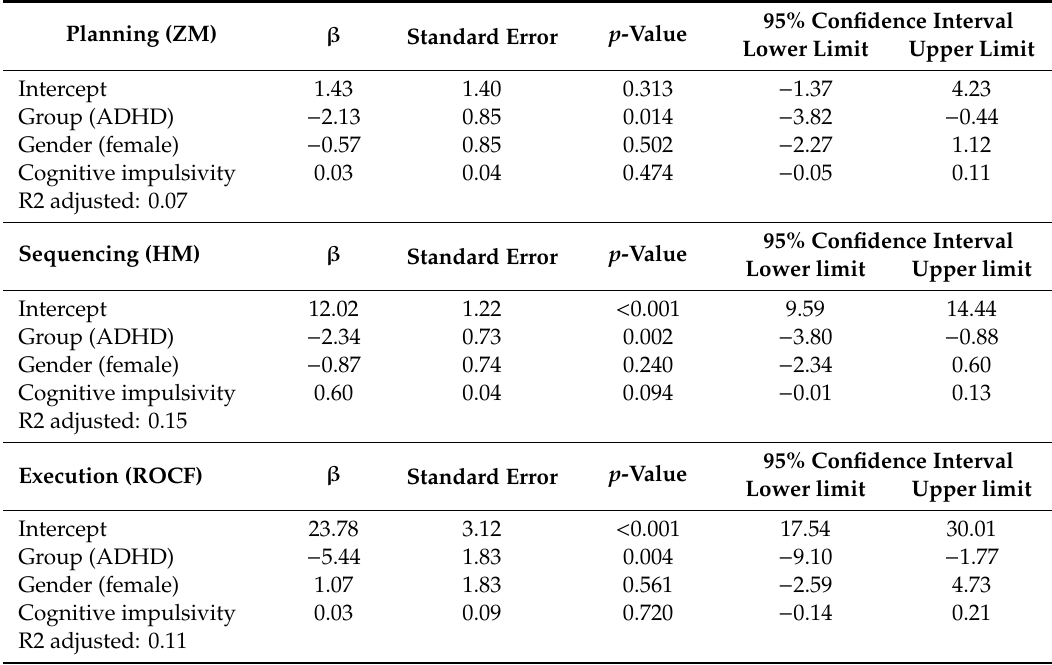
Table 3. Results of multivariate analysis of planning, sequencing, and